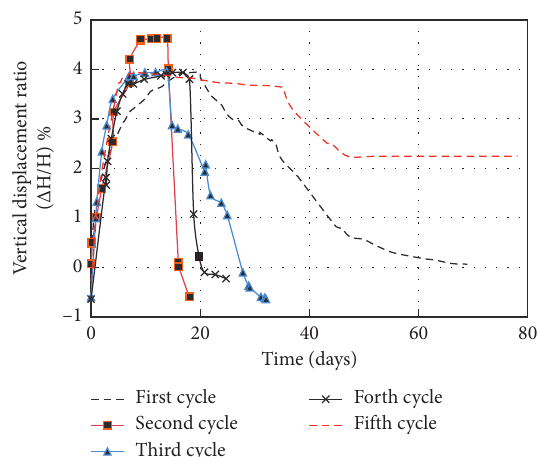
Figure 5: Vertical displacement ratio versus time for each cycle for UECS.